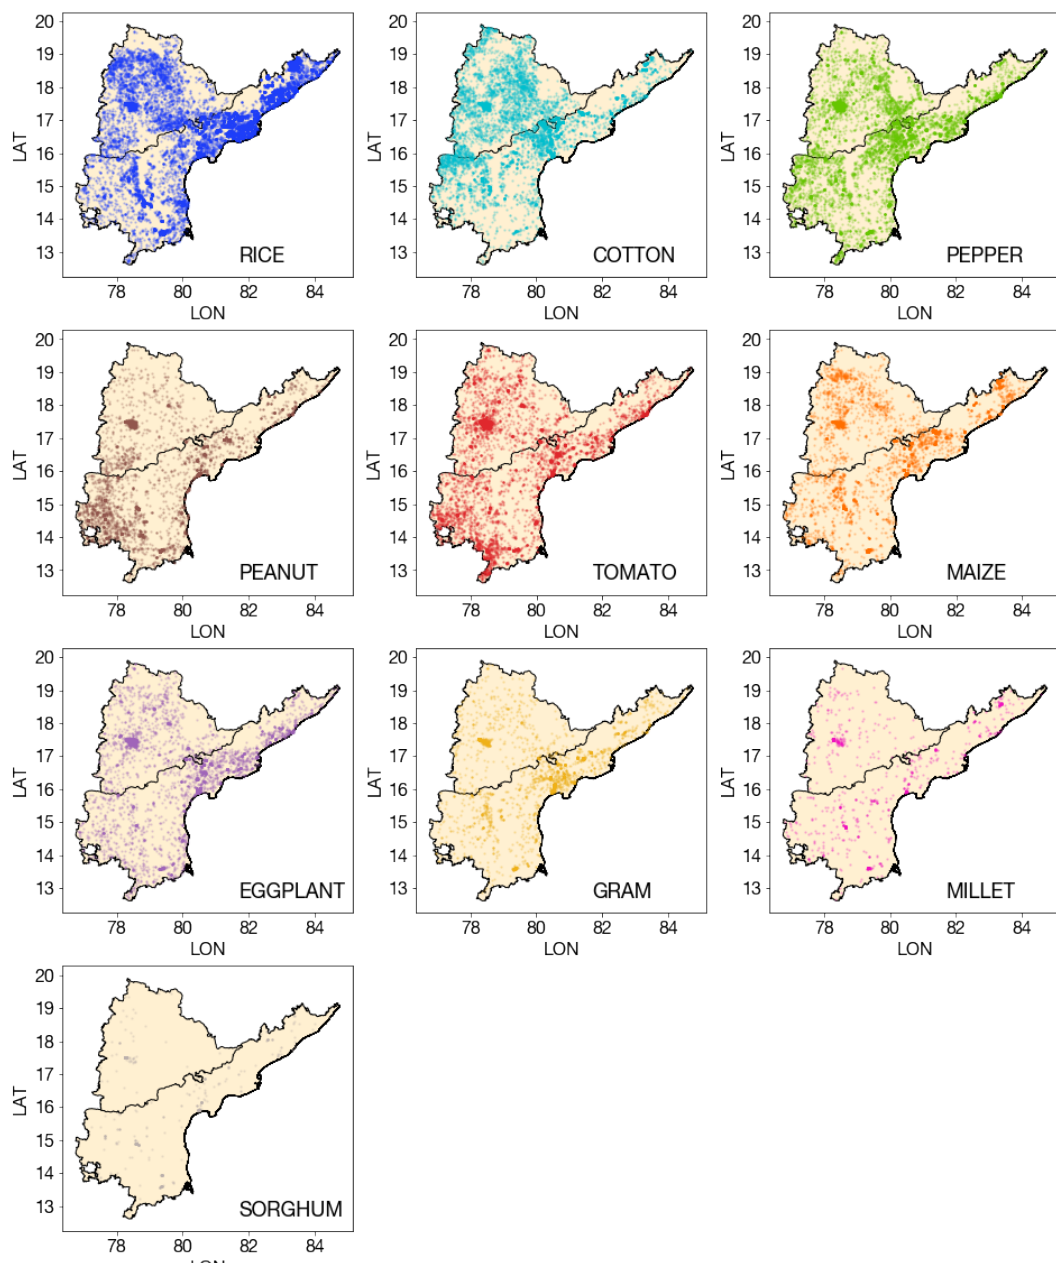
Figure A1. Geographic distribution of submissions for each crop type. Crops are ordered by number of submissions in the dataset, rice with the most and sorghum the